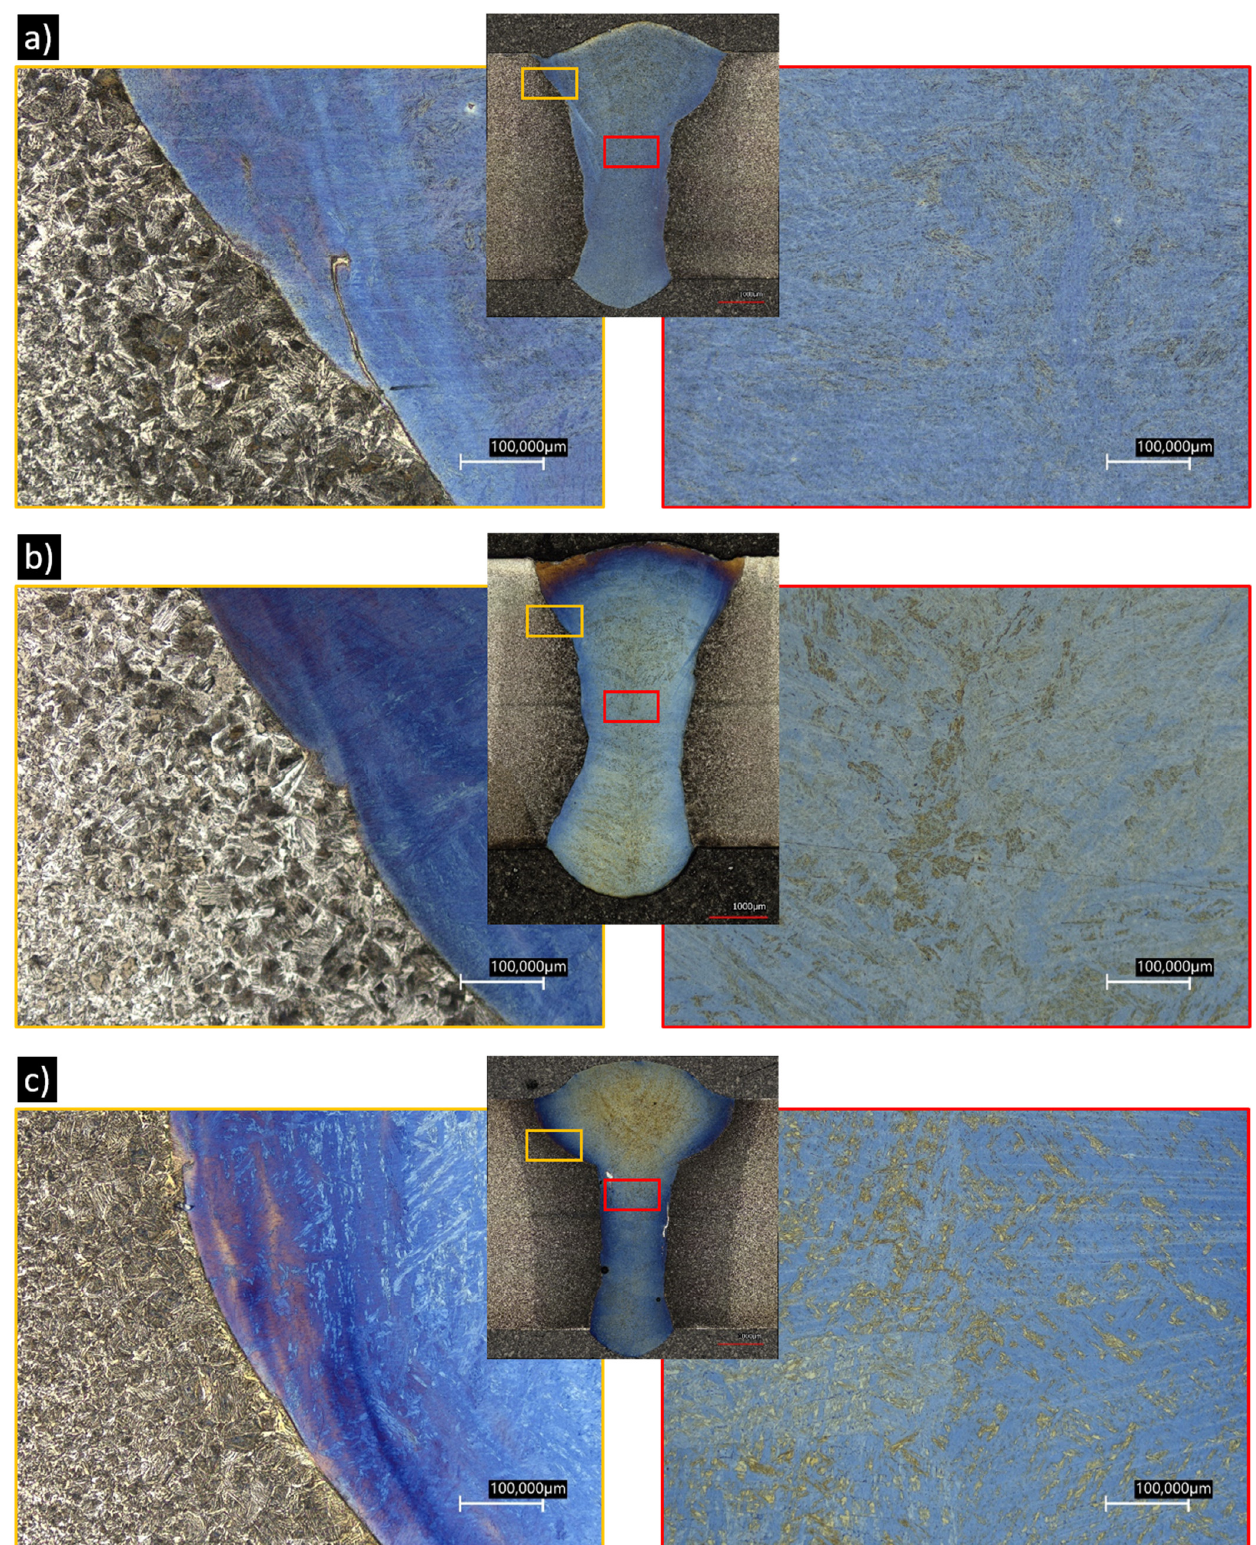
Figure 9. Color etching of the welded samples according to Lichtenegger and Bloech etchant (LBI).